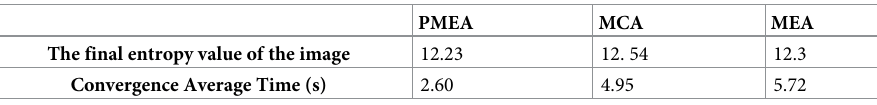
Table 3. Comparison of measured data results.